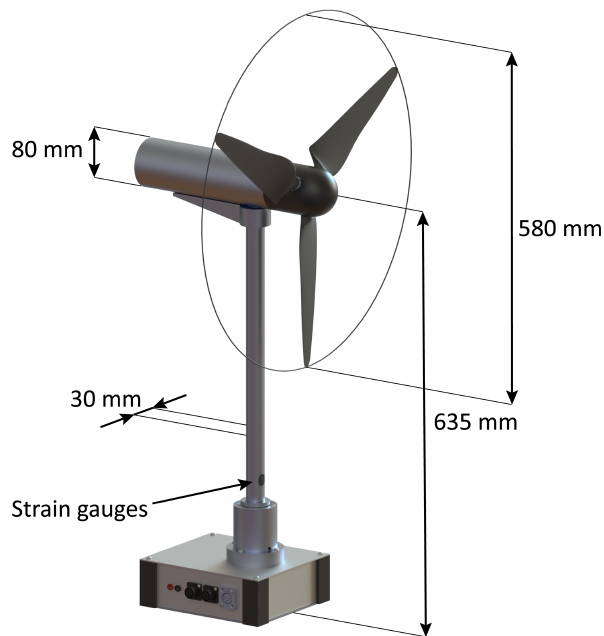
Figure 1. MoWiTO-0.6 wind turbine model including relevant di- mensions.